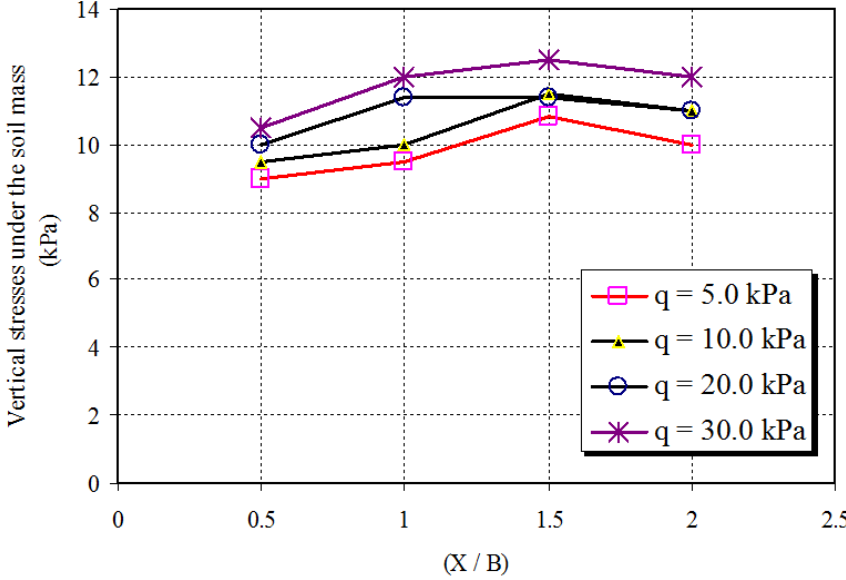
Figure 30. Influence of footing position on vertical stresses under the nailed soil mass.